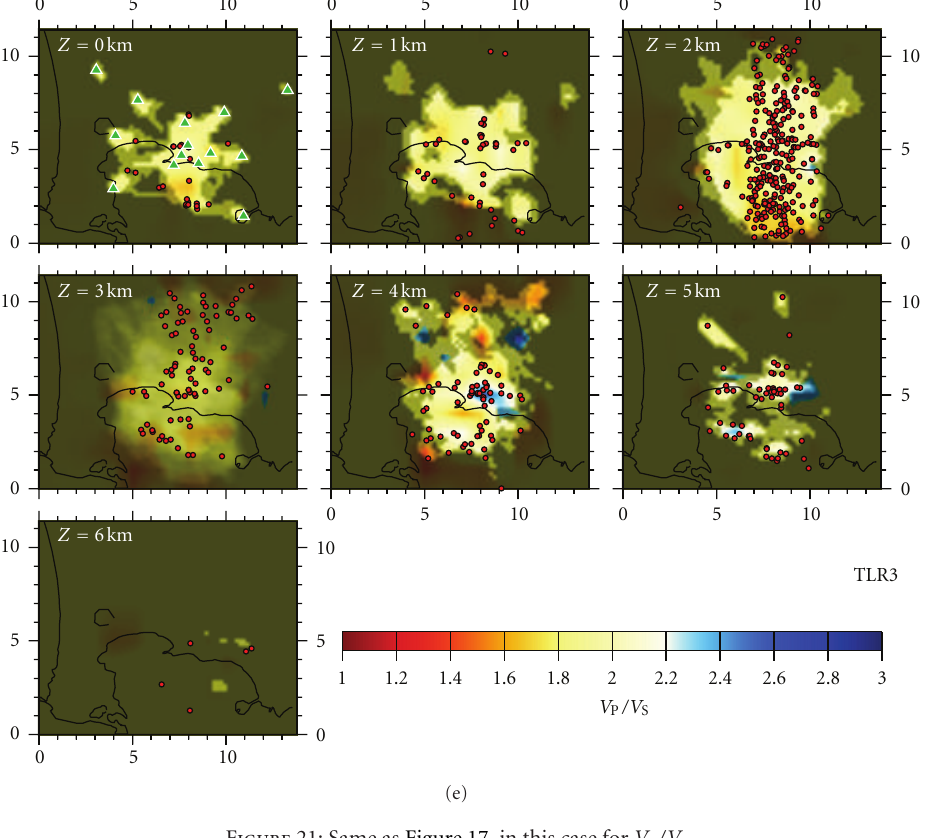
Figure 21: Same as Figure 17, in this case for V P /V S .